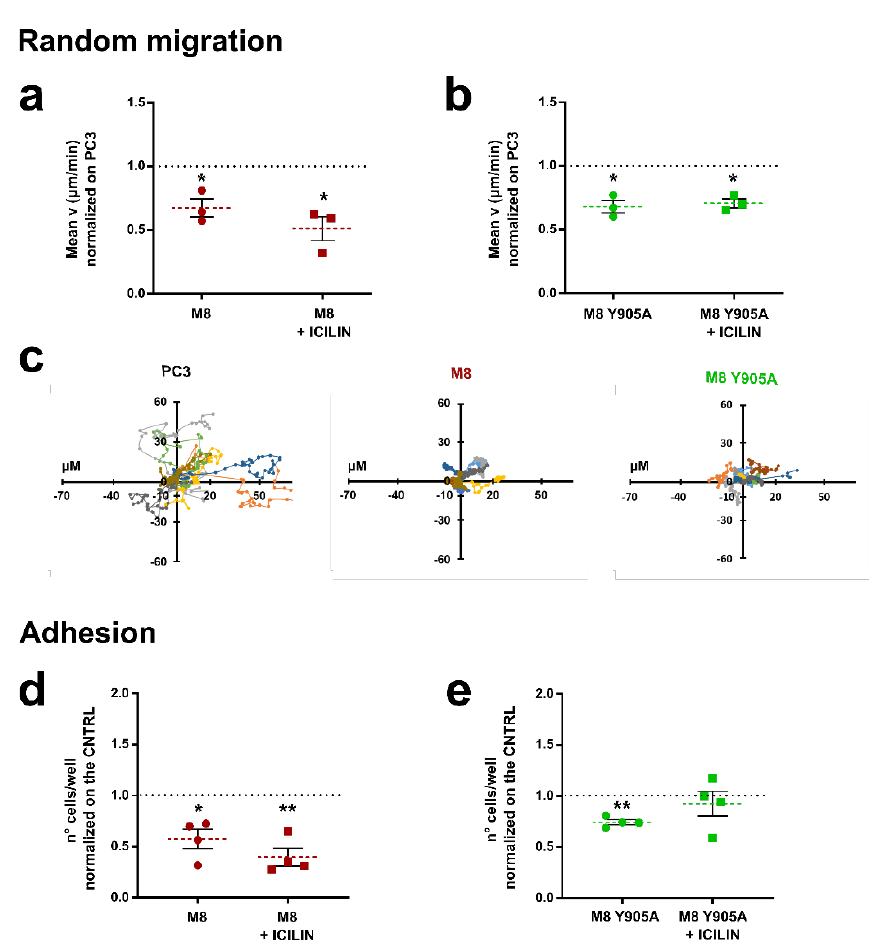
Figure 1. TRPM8 inhibits cell migration and adhesion independently of its channel activity. ( a ) Quantification of random migration assays on PC3 overexpressing TRPM8, treated or not with 10 µ M icilin. Data are normalized on PC3 or PC3 treated with icilin (controls represented by dot line) and displayed as mean ± SEM of three independent experiments. Statistical significance versus PC3 or PC3 treated with icilin, *: p < 0.05 (One sample t -test). ( b ) Quantification of random migration assays on PC3 overexpressing TRPM8 pore mutant, treated or not with 10 µ M icilin. Data are normalized on PC3 or PC3 treated with icilin (controls represented by dot line) and displayed as mean ± SEM of three independent experiments. Statistical significance versus PC3 or PC3 treated with icilin,*: p < 0.05 (One sample t -test). ( c ) Representative migration plots of PC3 (left panel), PC3 overexpressing TRPM8 (central panel) and PC3 overexpressing TRPM8 Y902A (right panel). Each line represents the trajectory of one cell within a 6 h period. Data shown refer to one field of one representative experiment out of three repeats (10 cells for each condition). ( d ) Quantification of adhesion assays on PC3 overexpressing TRPM8 treated or not with icilin (10 µ M). Data are normalized on PC3 or PC3 treated with icilin (controls represented by dot line) and displayed as mean ± SEM of four independent experiments. Statistical significance versus PC3 or PC3 treated with icilin *: p < 0.05; **: p < 0.01 (One sample t -test). ( e ) Quantification of adhesion assays on PC3 overexpressing TRPM8 pore mutant treated or not with icilin (10 µ M). Data are normalized on PC3 or PC3 treated with icilin (controls represented by dot line) and displayed as mean ± SEM of four independent experiments. Statistical significance versus PC3 or PC3 treated with icilin **: p < 0.01 (One sample t